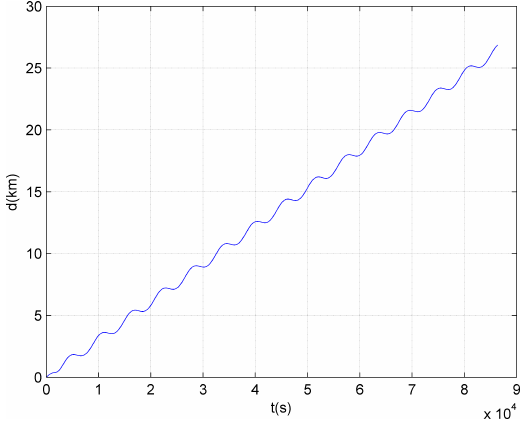
Figure 6. The relative distance between objects A and C.